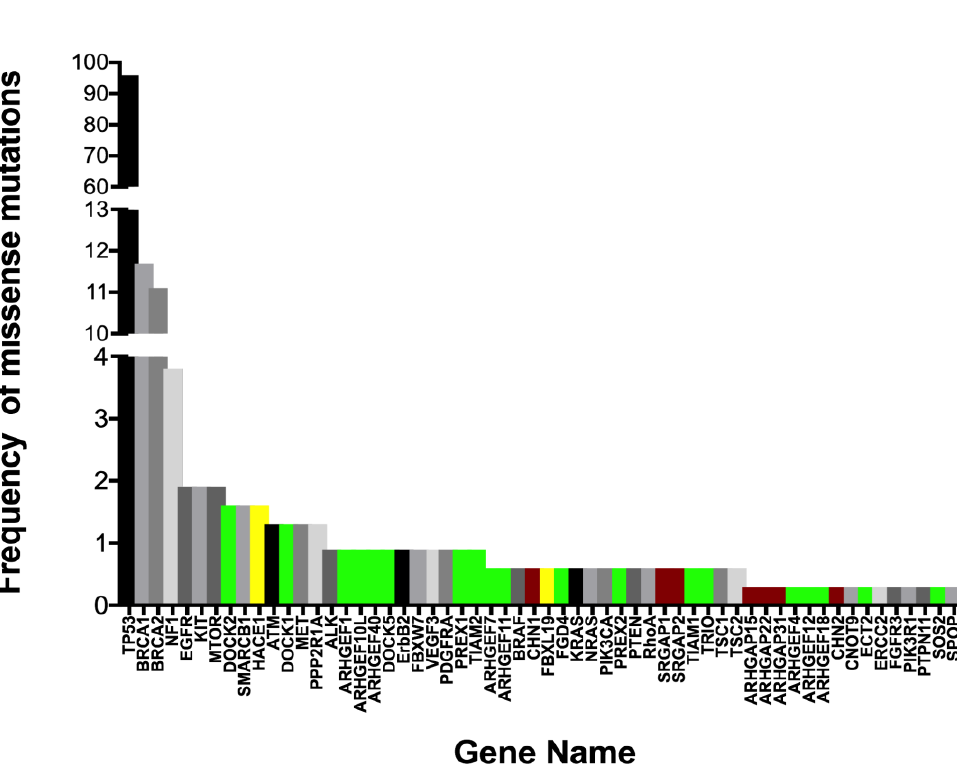
Figure 4. Rac1 regulators and effectors are part of the long tail of oncogenic drivers in ovarian cancer. A list of 54 genes with frequent missense mutations in cancers was derived from OncoKB: A precision oncology knowledge base and two recent publications on rare mutations. The cancer gene list was combined with a selected list of 28 Rac1 regulatory proteins (GEFs, GAPs, ubiquitin ligases). Plotted is the frequency of missense mutations in genes with mutation frequencies above 0 (58 of 82 analyzed) among 315 serous ovarian cancer patient samples in TCGA. The frequency for BRCA1 and BRCA2 gene mutations is the sum of somatic and germline missense mutations. For all other genes no germ line mutations are reported. Among the analyzed genes, 53 (9.2%) are Tier 1 of 574 reported in COSMIC v86; Tier 1 genes have “ documented activity relevant to cancer, plus evidence of mutations in cancer, which change the activity of the gene product in a way that promotes oncogenic transformation ”. Among the Rac1 regulators only ARHGEF12 and ARHGEF10L are validated as Tier 1 and Tier 2 (“ strong indication of a role in cancer ”), respectively. Cancer genes (black and gray), Rac1 GEFs (green), Rac1 GAPs (red), ubiquitin ligases (yellow). The data show that even though missense mutations in individual Rac1 regulators occur with low frequency, there are at least 26 possible targets (10 with co-occurring alterations, p < 0.05) that might lead to Rac1 activation or inactivation in ovarian cancer.